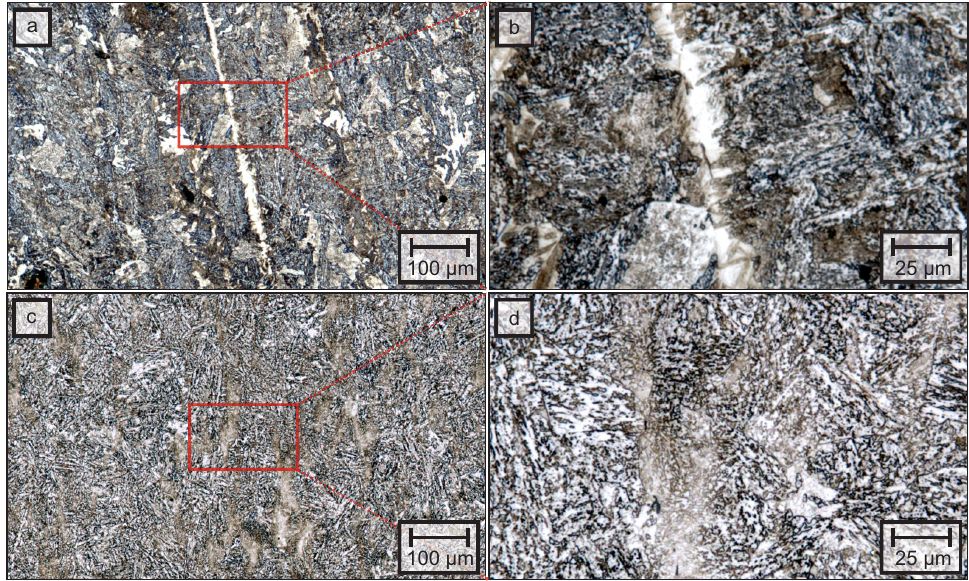
Figure 3. Microstructural inhomogeneities (superstructures) visible in the bainitic materials. The su- perstructures appear elongated when they are examined parallel to the rolling direction ( a , b ) and globular when examined vertical to the rolling direction ( c , d